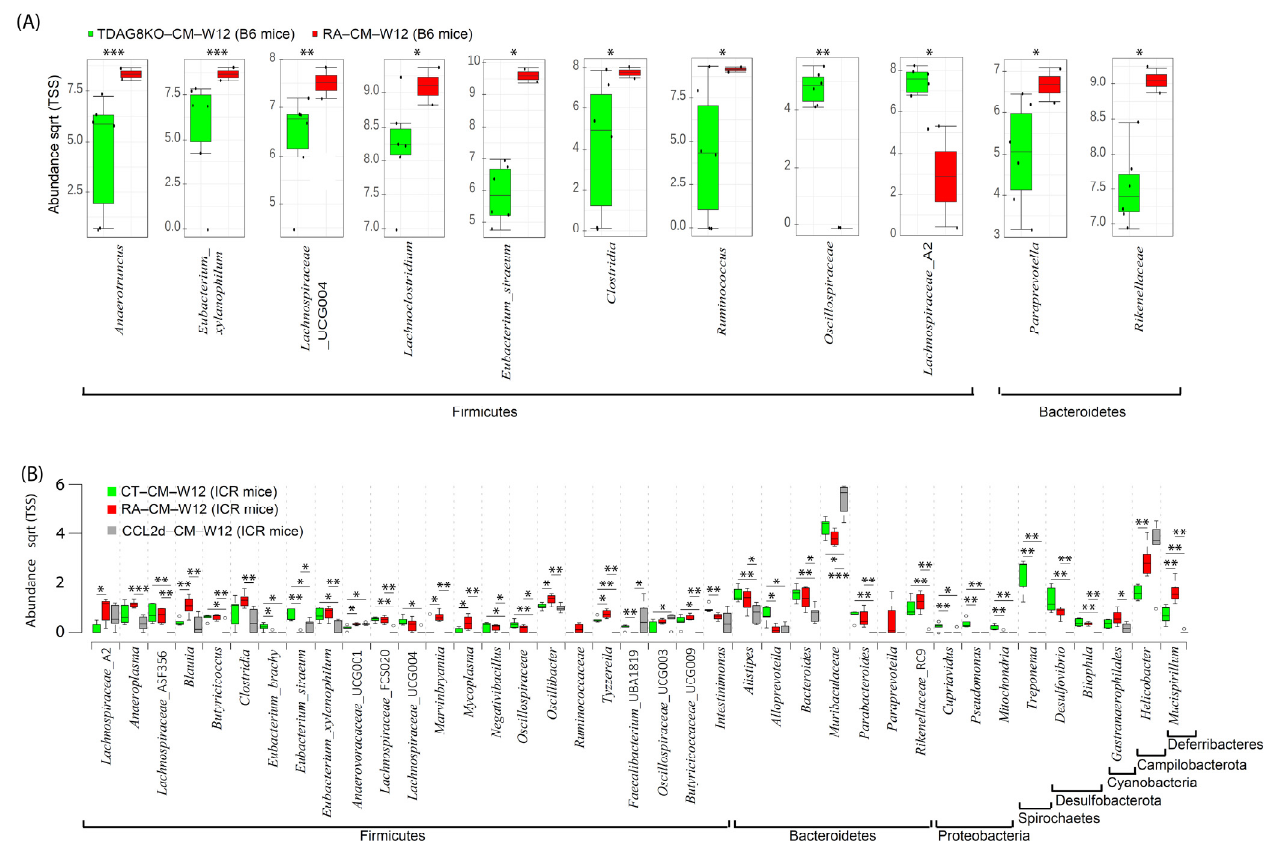
Figure 6. Composition of the cecal mucosa microbiome in healthy control, RA, TDAG8-deficient, and CCL-2d-treated mice at week 12. ( A ) Significantly abundant genera in RA and TDAG8-deficient B6 mice. ( B ) Significantly abundant genera in healthy control, RA, and CCL-2d treated ICR mice. Data are median (horizontal line), interquartile range (box edges) and range (whiskers). * p < 0.05; ** p < 0.01; *** p < 0.001, Wilcoxon rank-sum Table 4. Composition of the cecal mucus microbiome at weeks 1–12 and 12.